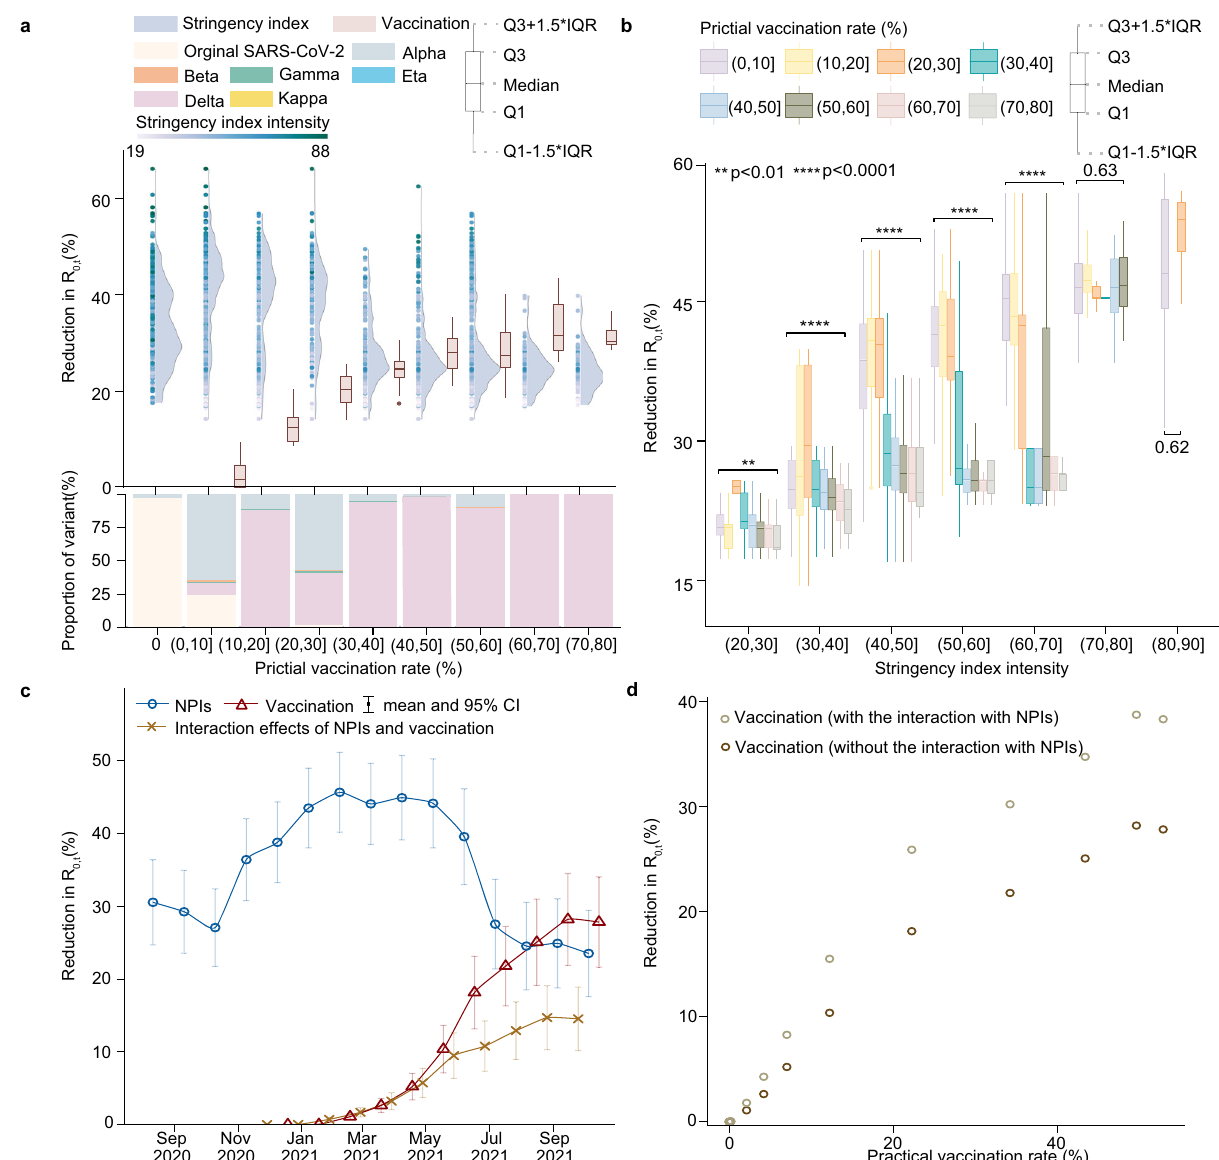
Fig. 3 The interaction effect of NPIs and vaccination on reducing COVID-19 transmission in populations across 31 countries. a The effects attributed to NPIs (raincloud plots in blue) and vaccination (boxplots in pink) under different practical vaccination rates. The raincloud plot visualises the intensity of stringency index (points) and the probability density of its effect. The boxplot presents the median and interquartile range. The stacked bar chart in the bottom illustrates the composition of COVID-19 variants under various vaccination levels from 1 August 2020 to 25 October 2021. The numbers of independent samples for boxplot from left (0 – 10% practical vaccination rate) to right (70 – 80% practical vaccination rate) are n = 4434, 962, 807, 900, 838, 1086, 497, and 187, respectively. b The effects of vaccines under different vaccination rates and stringency of NPIs. The effect of different practical vaccination rates within each NPI stringency group was assessed by one-way ANOVA (** p < 0.01, **** p < 0.0001). P-values are produced by two sided Wilcoxon test. The numbers of total independent samples form left (20< stringency index < = 30) to right (80< stringency index < = 90) are n = 466, 1334, 2173, 2055, 1805, 1387, and 459, respectively. c The respective effects attributed to NPIs (in blue) and vaccination (in red), and the interaction effect between NPIs and vaccination (in yellow) over time across 31 countries. d The comparison of vaccination effects with/without the interaction with